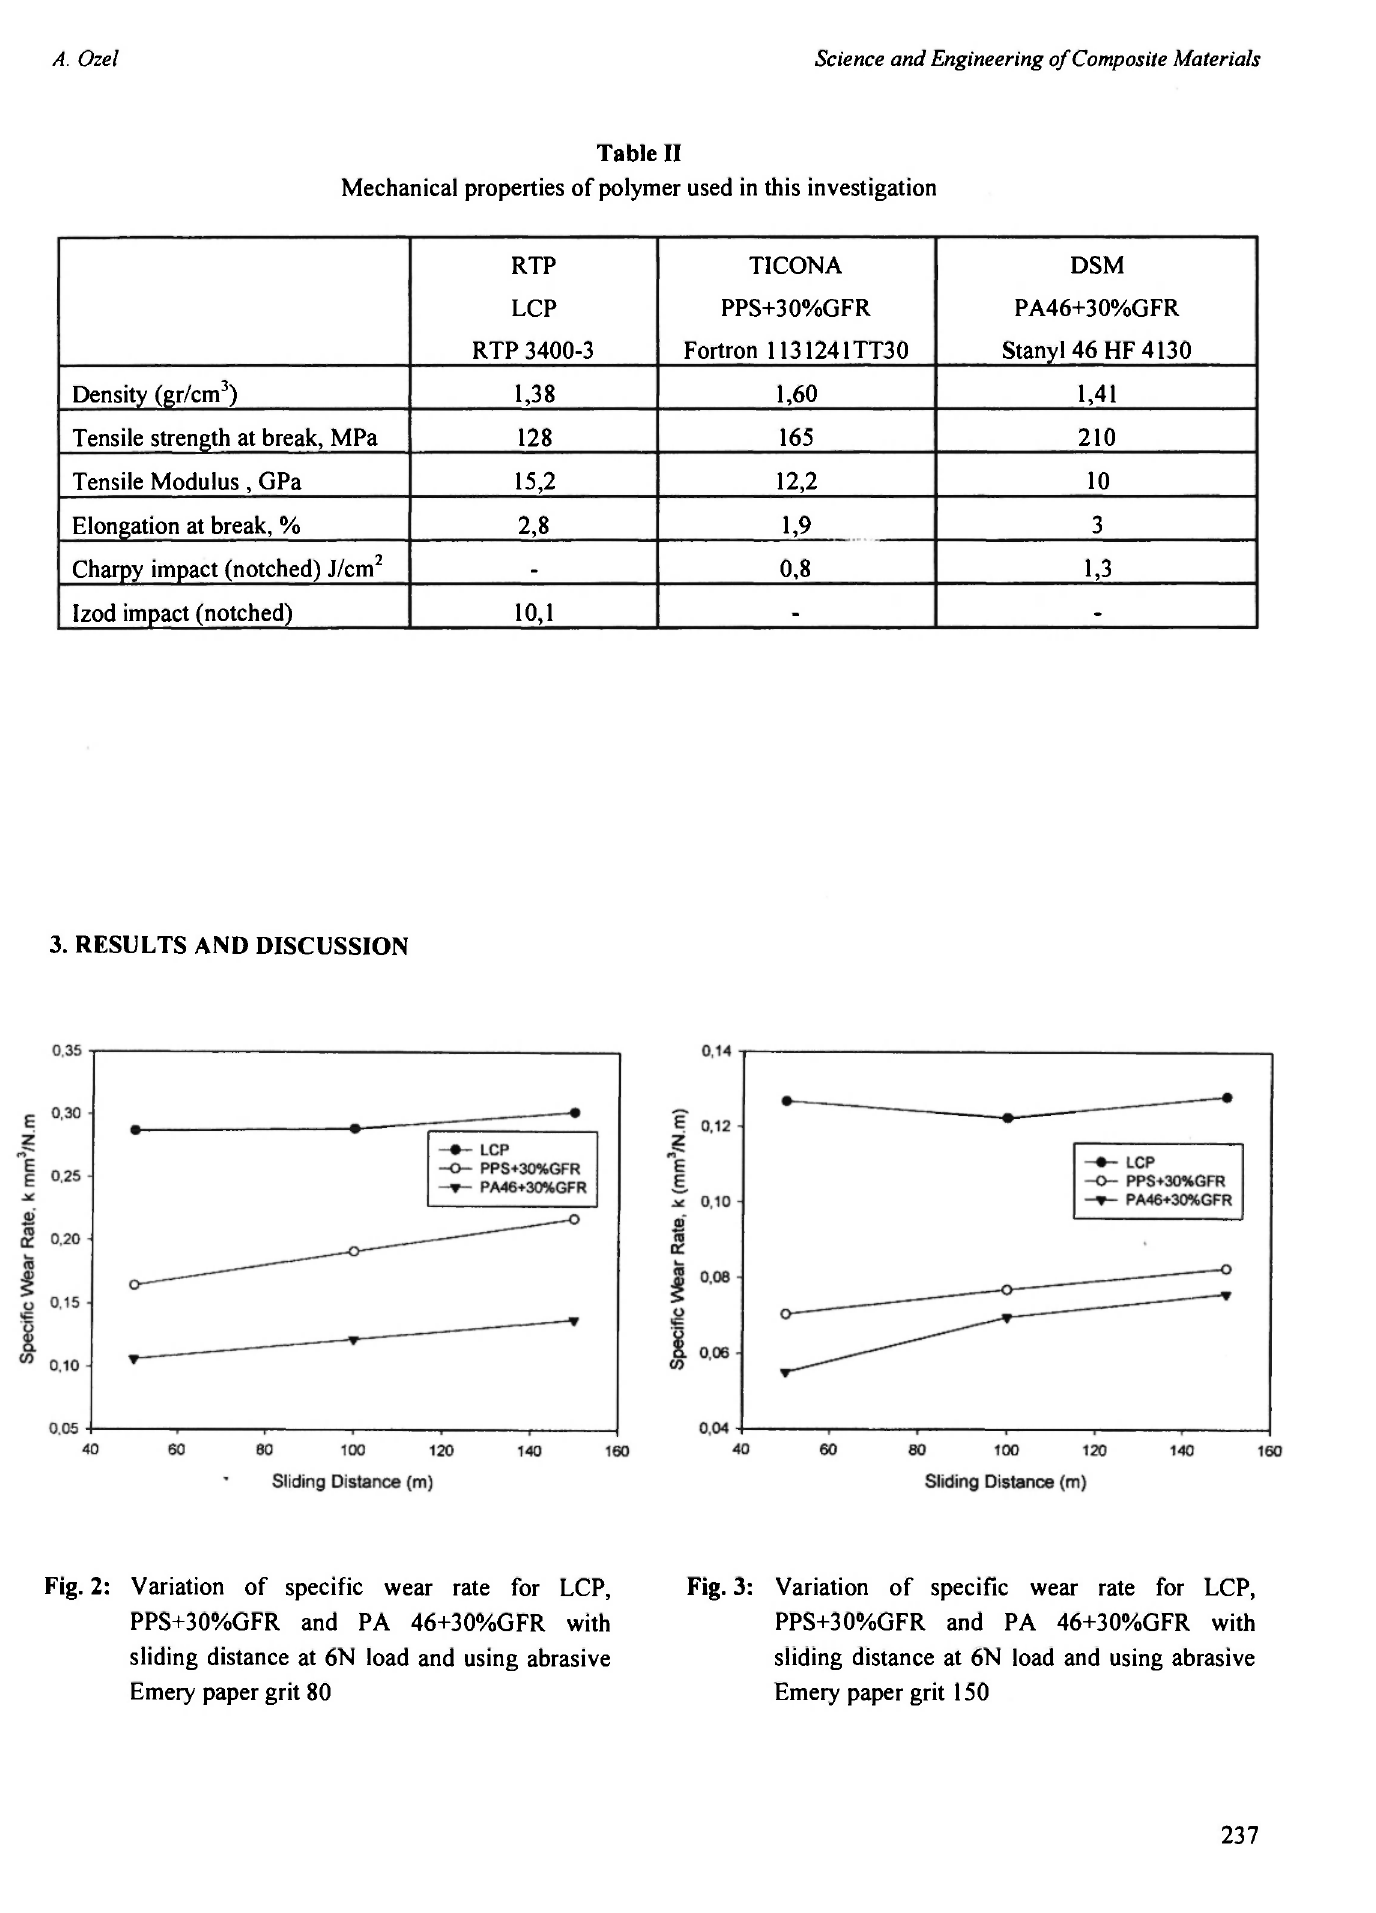
Fig. 3: Variation of specific wear rate for LCP, PPS+30%GFR and PA 46+30%GFR with sliding distance at 6N load and using abrasive Emery paper grit 150